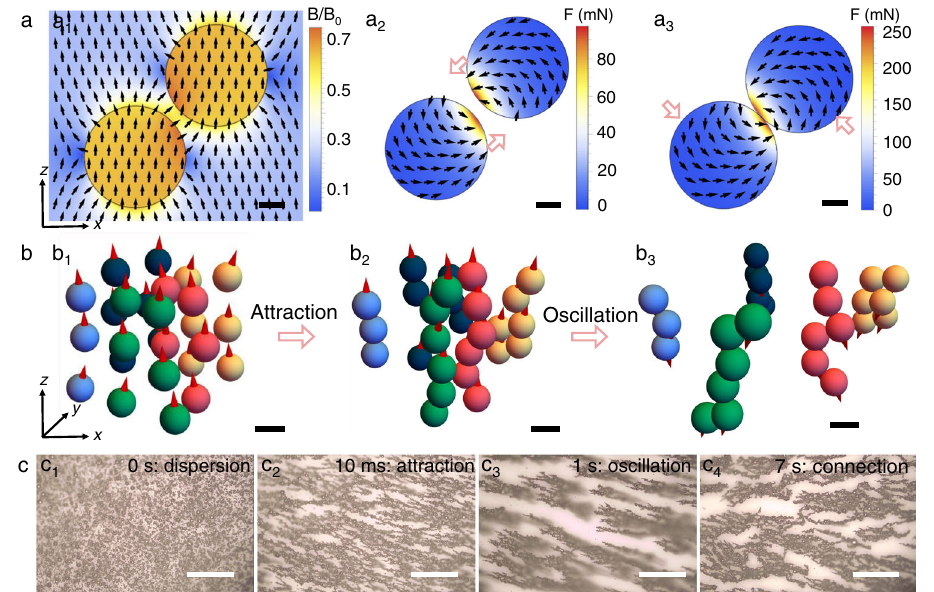
Fig. 3 | Magnetic simulations of interaction of magnetic microparticles under AMF. a Static simulations revealing interaction between two Ni 81 Fe 19 micro- particlesexposedtoahomogeneousexternalmagnetic fi eld. a 1 Magneticstray fi eld distribution and a 2 force distribution as two microparticles are apart, corre- sponding to a very early stage of applying AMF. B 0 indicates the saturation fi eld of Ni 81 Fe 19 microparticles. a 3 Force distribution as two microparticles are in contact. Pinkarrowsqualitativelyportraythemaindirectionofthenetforceexperiencedby microparticles. Scale bars in a): 1 μ m. b Dynamic simulations revealing interaction between27Ni 81 Fe 19 microparticles exposed to AMF. Screenshotsof microparticles